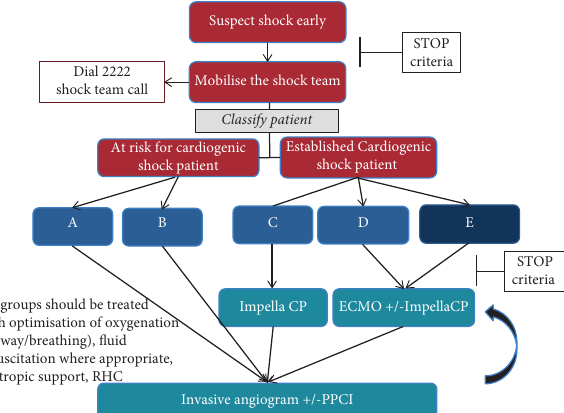
Figure 4: Proposed treatment algorithm for patients presenting with acute coronary syndromes and shock. Early use of mechanical circulatory support is advocated for patients in the C-E